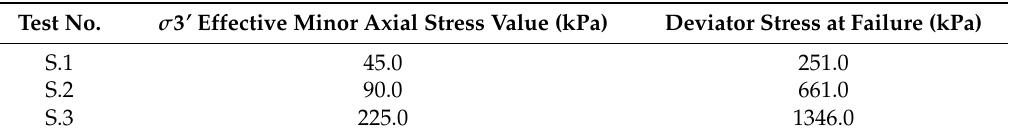
Figure 3. Results of static tests on RCA: ( a ) the California Bearing Ratio (CBR) test results and ( b ) the direct shear test (DST) results. Table 2. The test results of the drained static triaxial tests.